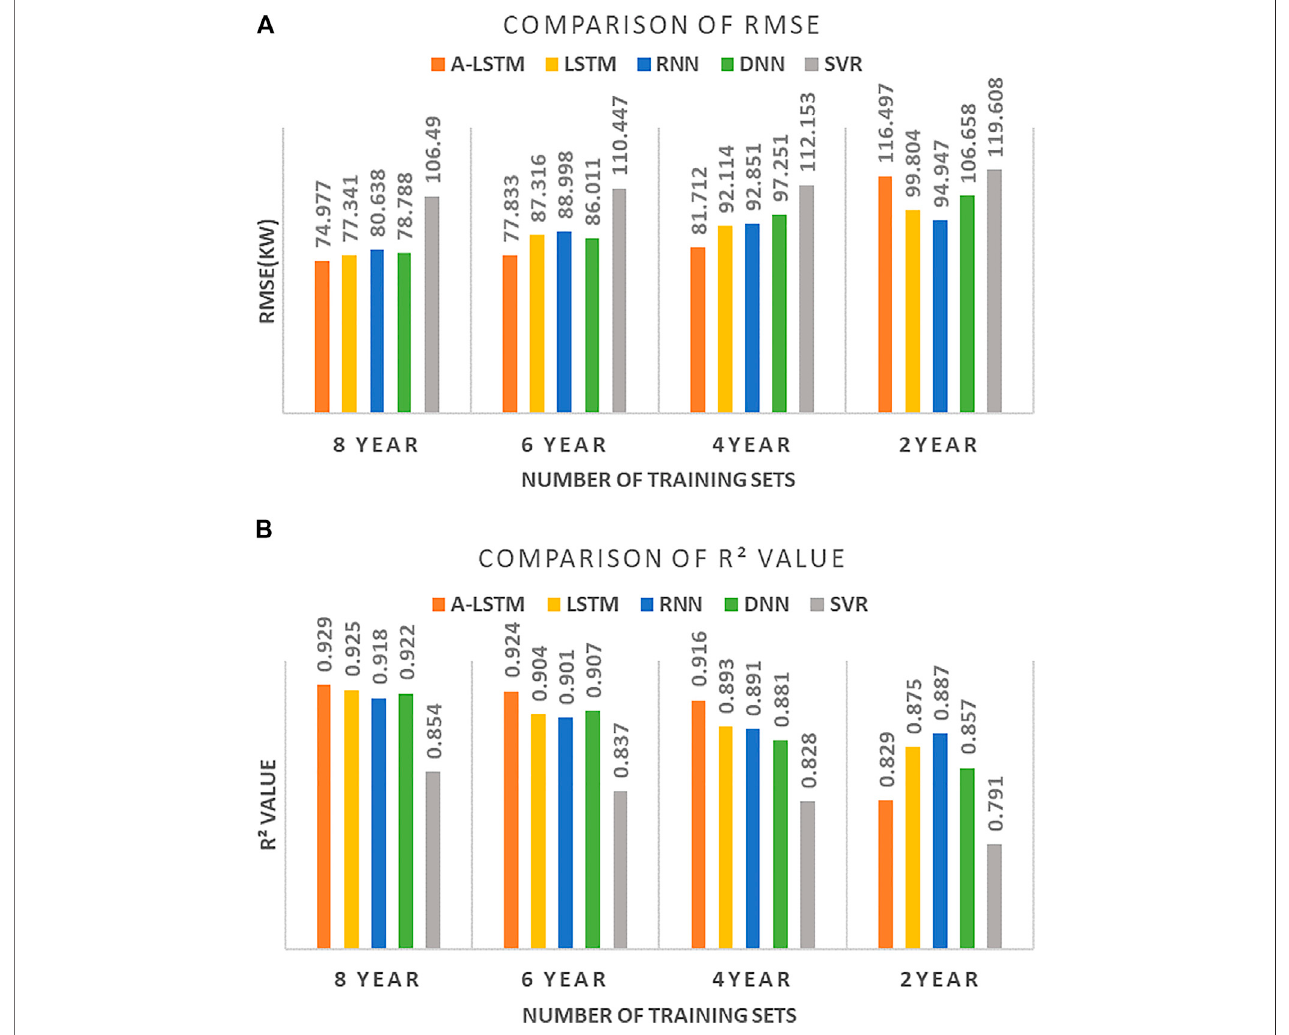
FIGURE 8 | The prediction accuracy of each model under different lengths of training set: (A) the comparison of RMSE, (B) the comparison of R 2 value.